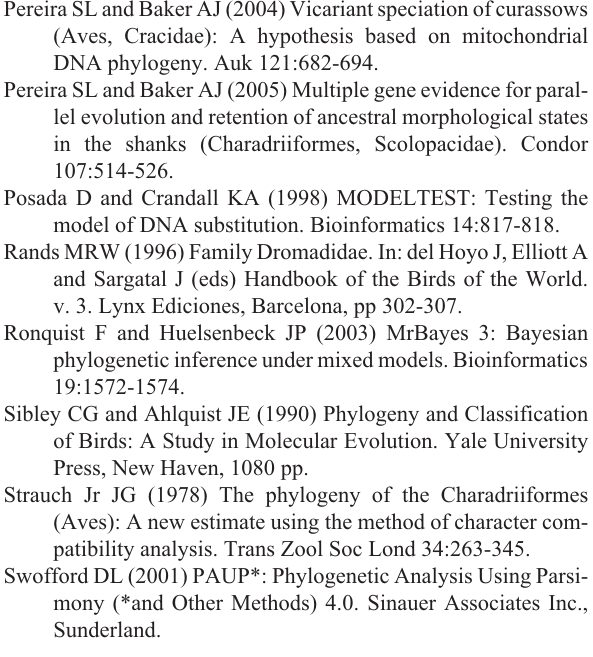
Figure S1 – Consensus Bayesian tree derived from the total evi- dence